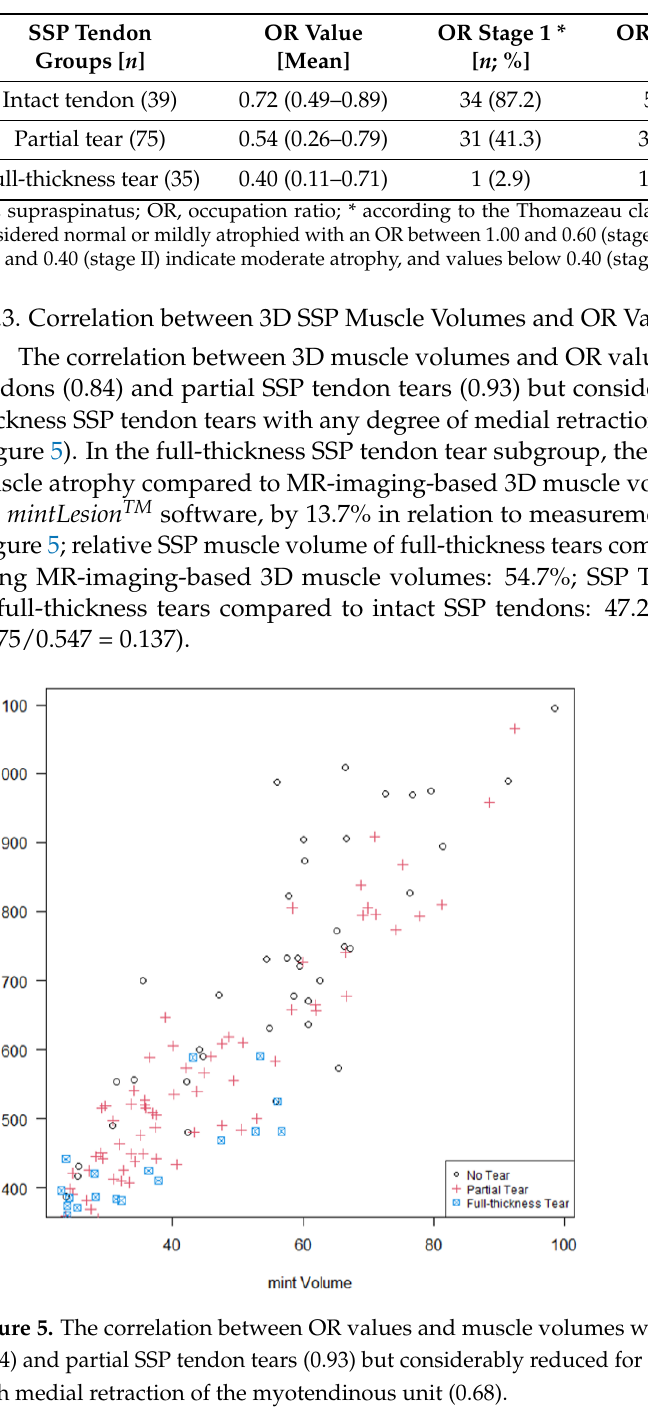
Table 4. Supraspinatus fossa OR values in the patient cohort.